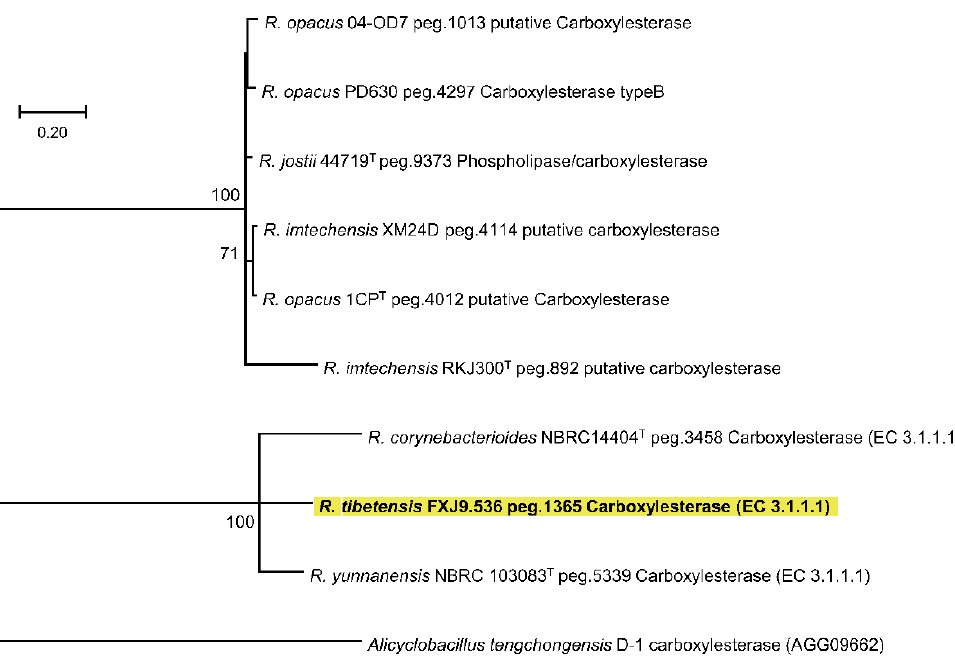
Figure 5. Maximum-likelihood phylogenetic tree based on amino acid sequences of the putative carboxylesterase genes. The carboxylesterase sequence associated with malathion degradation in Alicyclobacillus tengchongensis D-1 was used as an outgroup. Only bootstrap values above 50% are given. Bar, 0.20 substitutions per site.